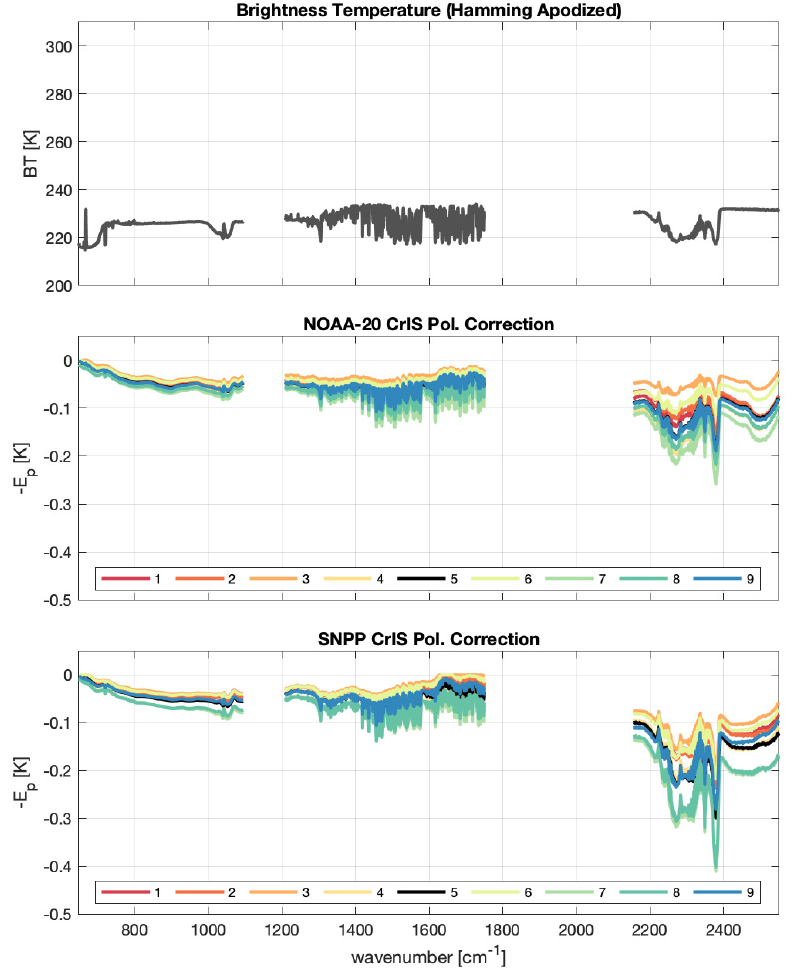
Figure 19. FOV and sensor dependence of the polarization correction for an example of an Antarctic observation.